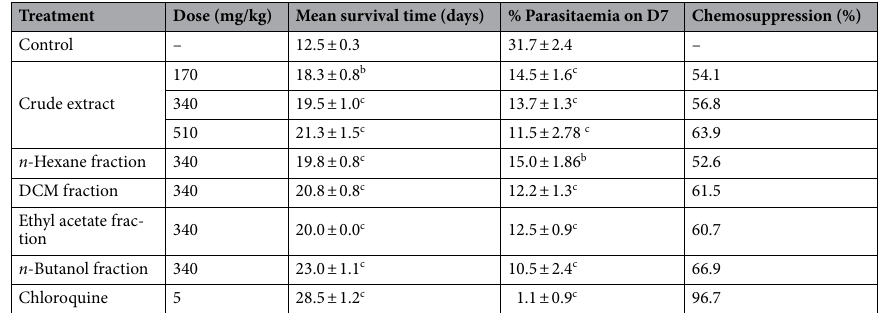
Table 4. Mean survival time of mice treated with leaf extract and fractions of S. officinarum during established P. berghei infection in mice. Values are expressed as mean ± SEM. Significance relative to control. a p < 0.05; b p < 0.01; c p < 0.001. n = 6.